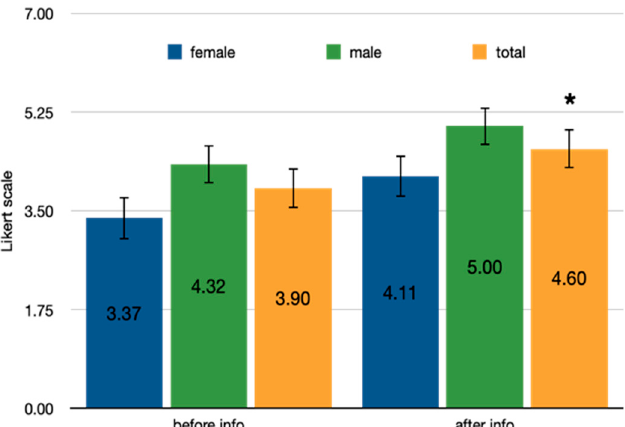
Figure 2. Willingness to taste an energy bar enriched with cricket flour, pre and post treatment. Difference in mean score in Likert scale, ranging from 1 = strongly disagree to 7 = strongly agree on the willingness to taste the cricket bar, before and after the information, among gender and the whole sample; willing to taste significantly increases in the reference sample * p < 0.001.